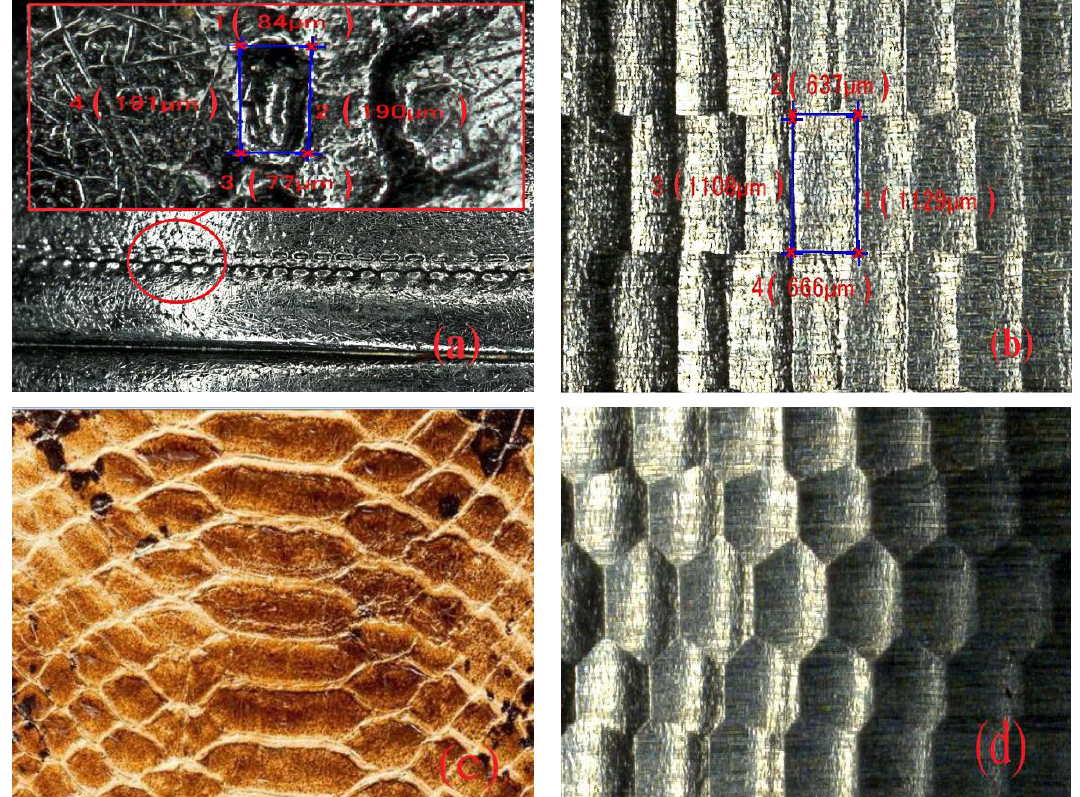
Figure 1. Different biomimetic designs and non-smooth pit surface forms. ( a ) Biomimetic design of quadrilateral pit on dung beetle body; ( b ) biomimetic form of quadrilateral pit after high-speed milling; ( c ) biomimetic design on abdomen of desert viper; ( d ) biomimetic form of hexagonal pit after high-speed milling.